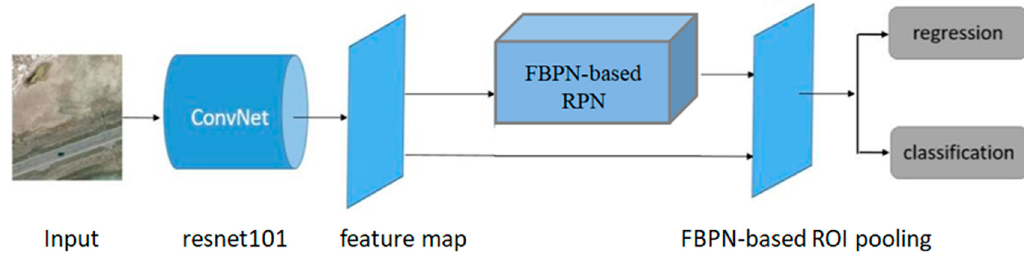
Figure 1. Overview of the proposed framework.